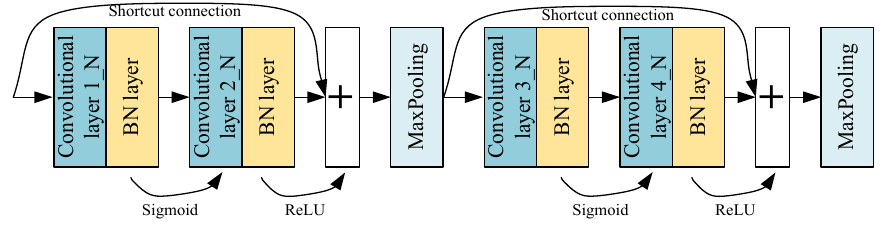
Figure 2. Parallel fusion residual block.